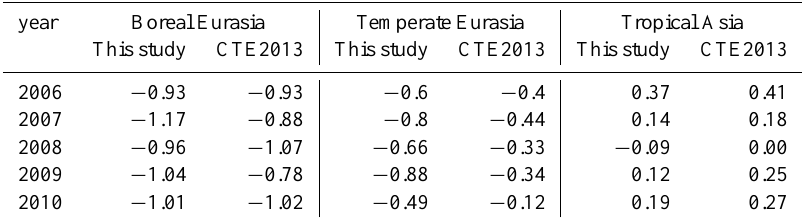
Table 8. Comparison of IAVs of the terrestrial ecosystem carbon fluxes in Asia during the period 2006–2010 from this study with